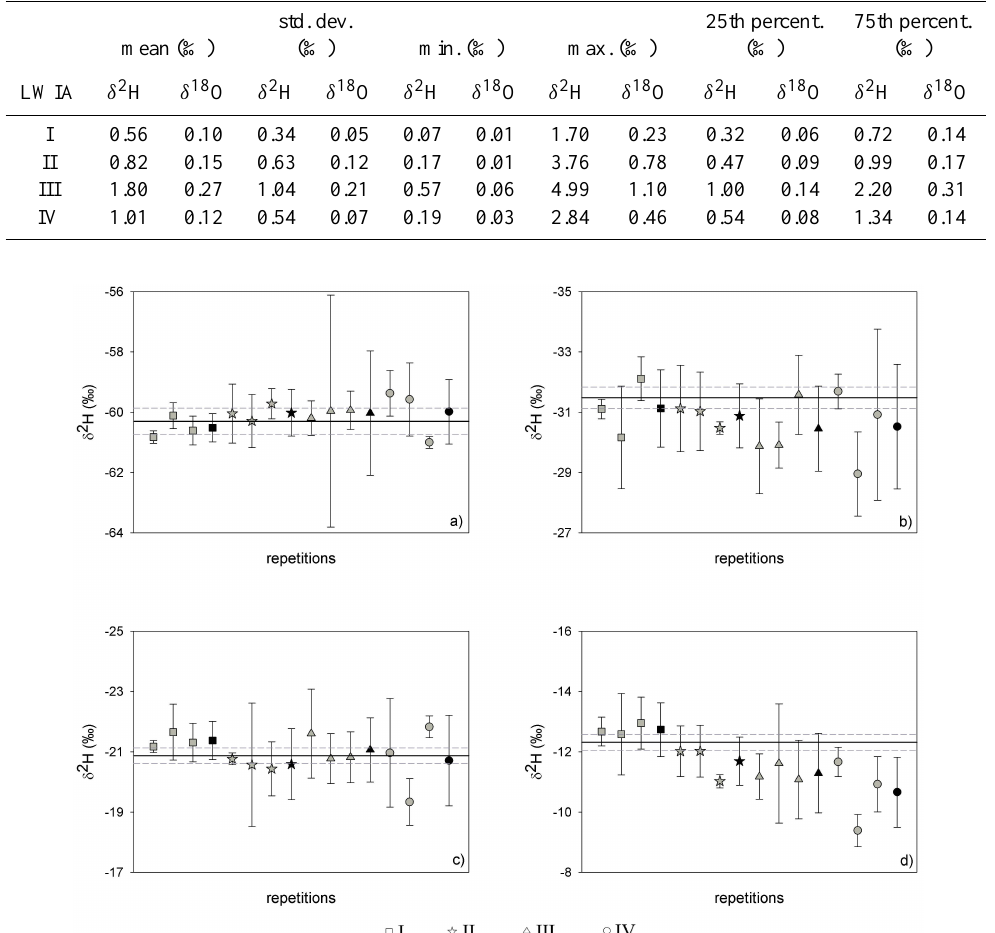
Fig. 7. Repeatability plots of δ 2 H measurements (A1 scheme). The mean value among the three repetitions is represented by the darker symbol. Solid and dashed horizontal lines represent the mass spectrometer δ 2 H measurement and the standard deviation, respectively. Samples: (a) 14; (b) 25; (c) 23; (d) 24.